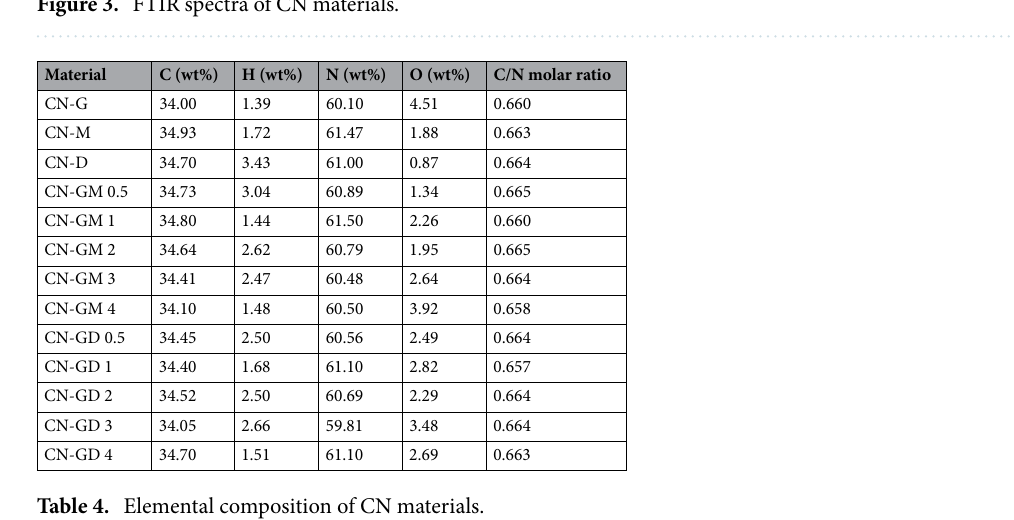
Figure 3. FTIR spectra of CN materials.